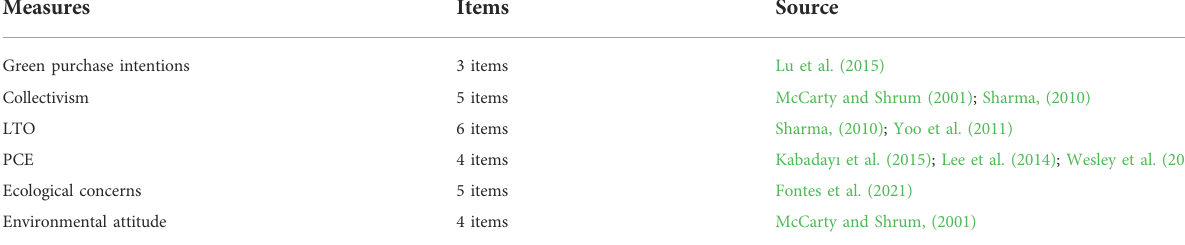
TABLE 2 A summary of the scale.